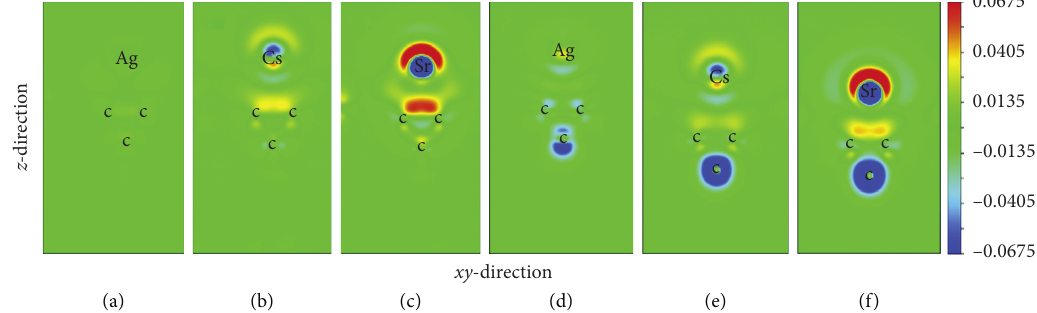
Figure 6: Charge density difference (CDD) based on the green bash lines shown in Figures 4(b) and 4(c) of Ag, Cs, and Sr on matrix graphite surface. (a–c) Matrix graphite surface with “bridge” defect; (d–f) matrix graphite surface with “spiro” defect. Red and blue areas represent positive and negative charge differences. Isosurface level was set at 0 . 0069e/˚A 3 .